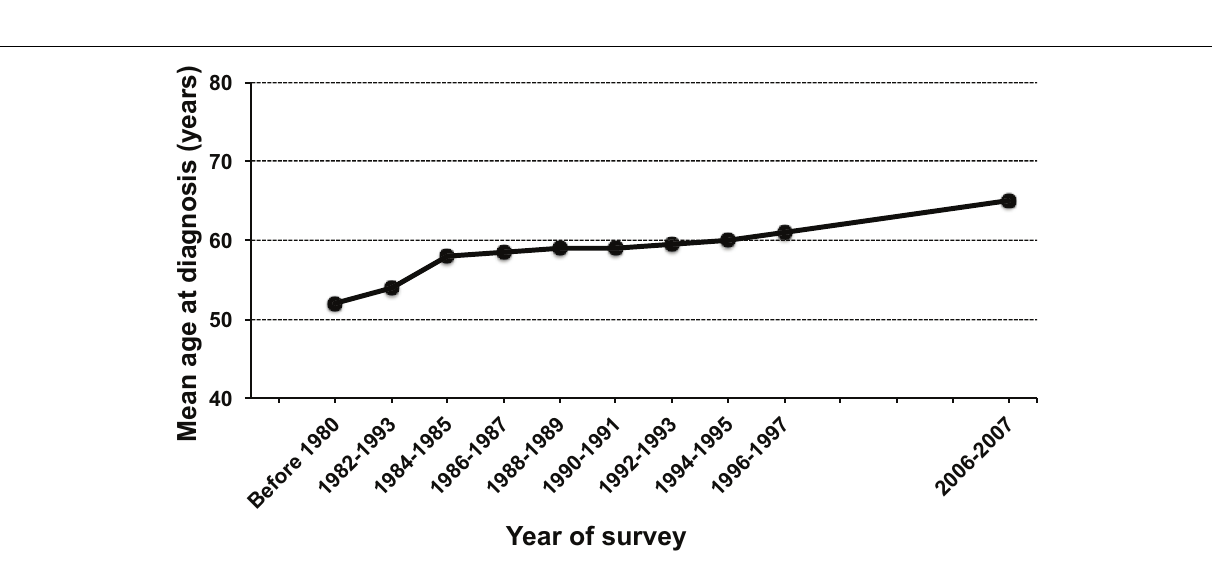
EAST ASIA (EXCLUDING